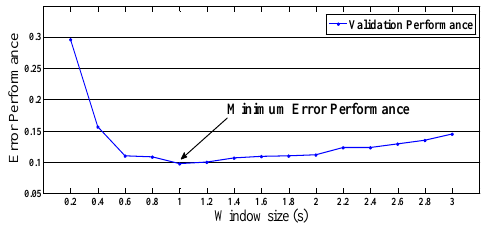
Fig. 6. Error performance as a function of window size